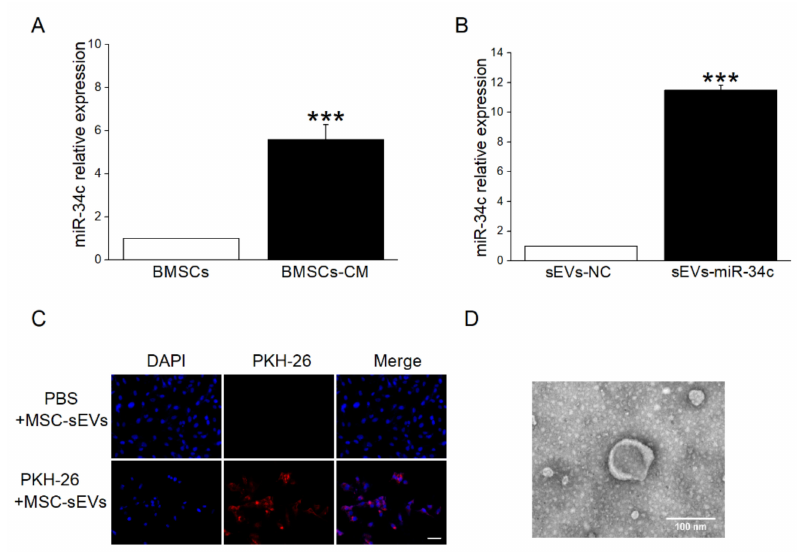
Figure 3. The sEVs derived from BMSCs could be taken into recipient cells. ( A ) The qRT-PCR analysis of miR-34c levels in BMSCs and BMSCs-CM ( n = 4). ( B ) MiR-34c levels in miR-34c-overexpressing sEVs (sEVs-miR-34c) or empty vector sEVs (sEVs-NC) ( n = 4). ( C ) Immunofluorescent detection of sEVs labeled with PKH26 after incubation with H441 cells for 20 h. Nuclei were counterstained by DAPI (blue; left panel), and the representative staining images are shown in PKH26-labeled sEVs (red; middle panel). The merged images are seen (right panel). Scale bar = 50 µ m. ( D ) Morphology of BMSC-sEVs observed under TEM. Scale bar = 100 nm. Note: *** p < 0.001, compared with BMSCs group and sEVs-NC